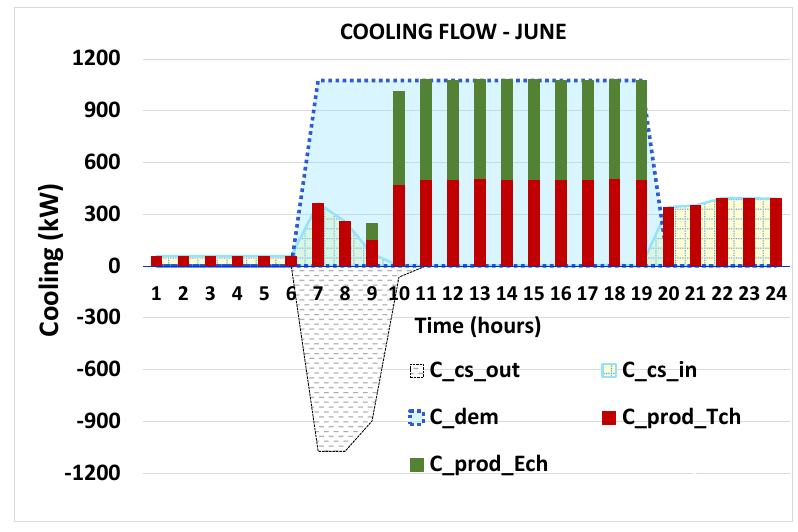
Figure 10. Cooling provided by the electric chiller (C_prod_Ech) and thermal chiller (C_prod_Tch), cooling to/from the cold storage (C_cs_in, C_cs_out) and cooling demand (C_dem).